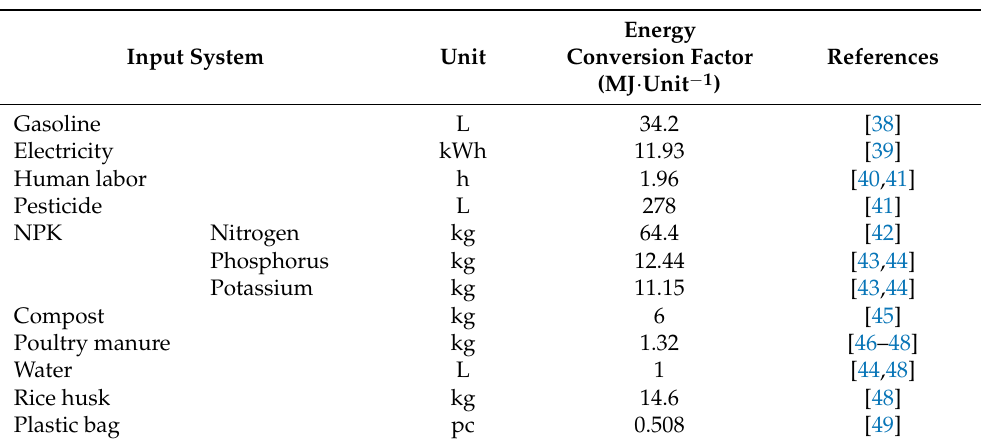
Table A4. Energy conversion factors.